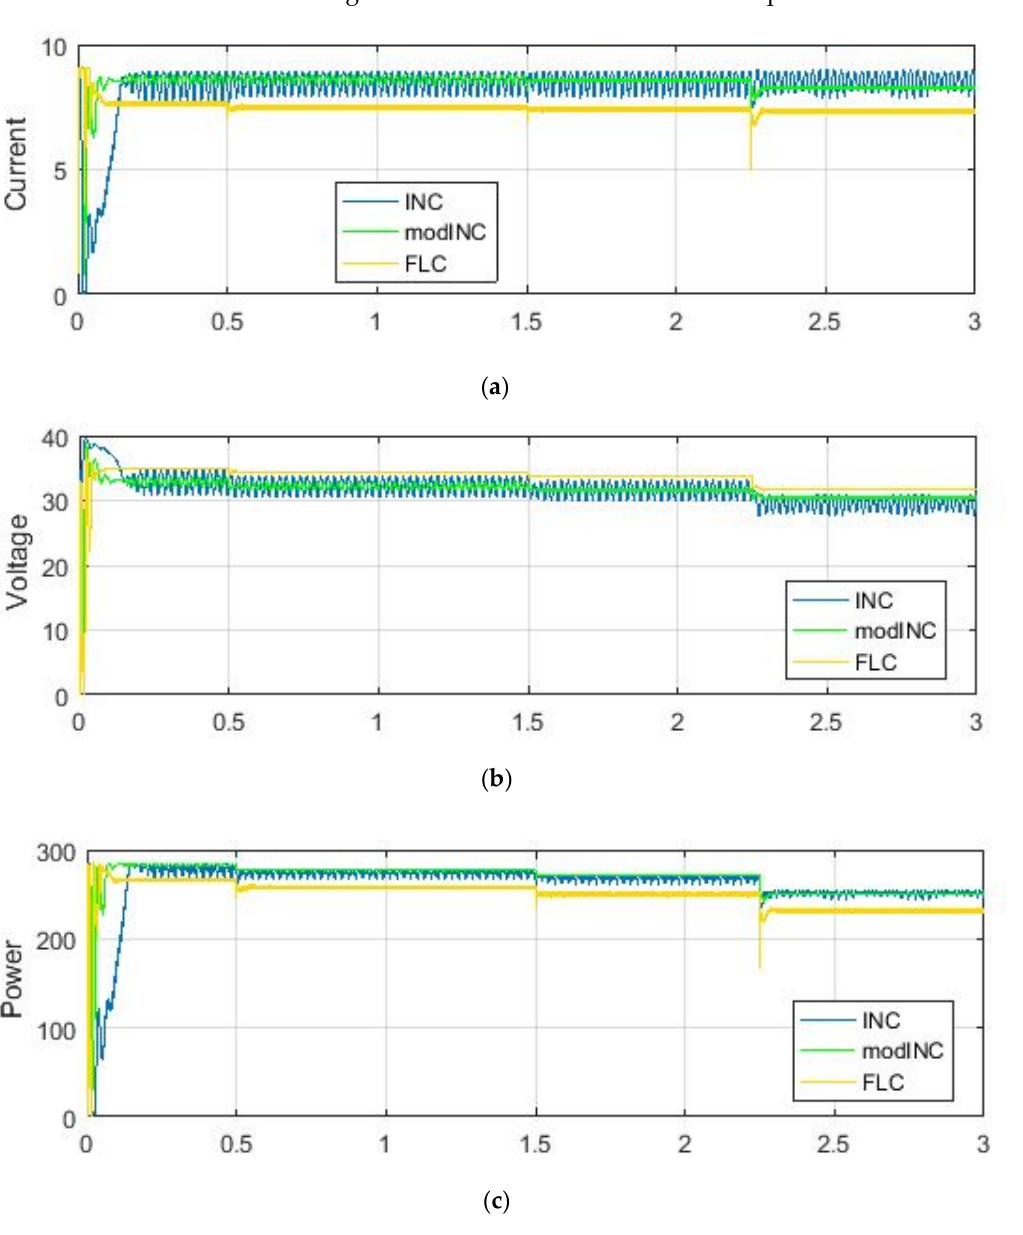
Figure 11. ( a ) Output current using INC, modINC, and FLC, by changing the temperature. ( b ) Output voltage using INC, modINC, and FLC, by changing the temperature. ( c ) Output power using INC, modINC, and FLC, by changing the temperature.